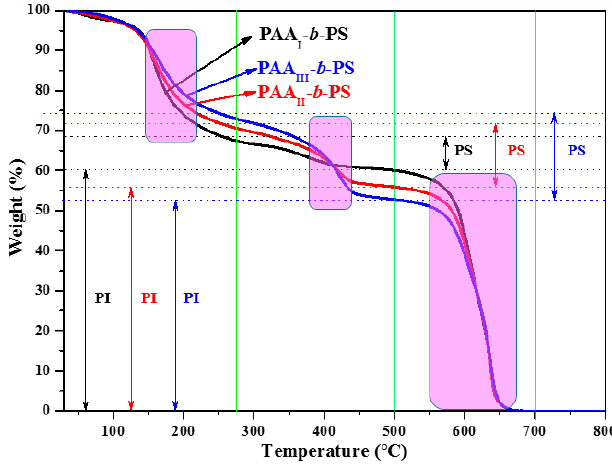
Figure 3. TGA curves of three block copolymers. The three transitions can be found in pink boxes from left to right: dehydration of PAA, decomposition of PS block and decomposition of PI block. After the transition of dehydration of PAA, PAA- b -PSs transform into PI- b -PSs. According to TGA curves, PI- b - PS and PI exist at 275 °C and 500 °C, respectively; no polymer exists at 700 °C. Therefore, f VPS can be obtained, as shown in Table 2. Table 2. Volume fractions of PS block of PI- b -PS from PAA- b -PS.